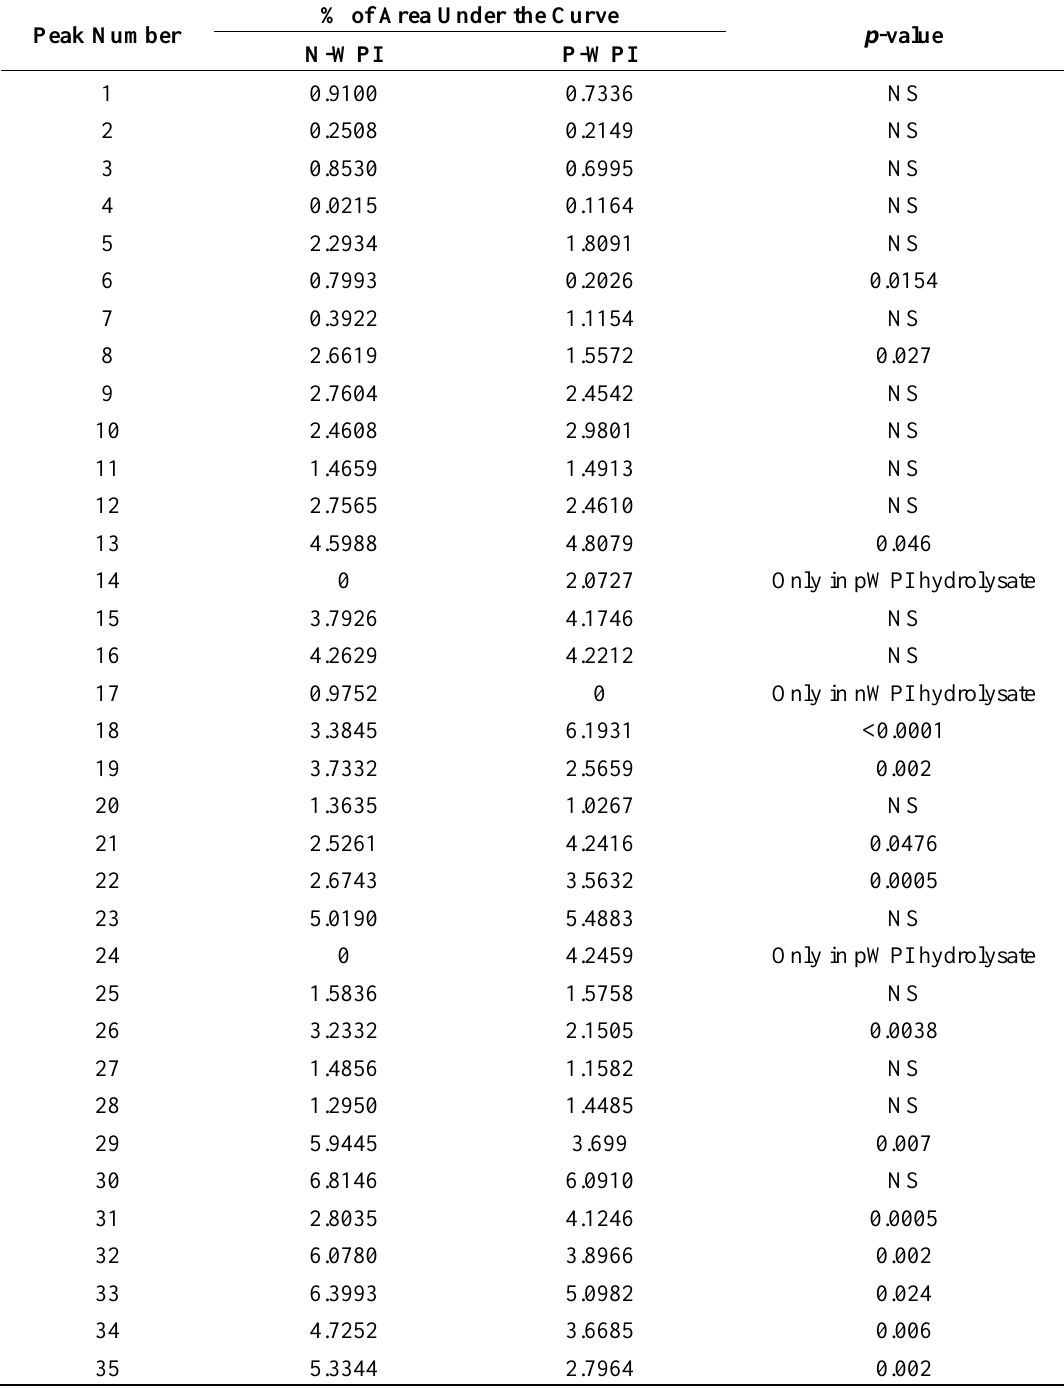
Table 2. Differences in percent peak areas between nWPI and pWPI hydrolysates, relative to the total area under the curve, as assessed by